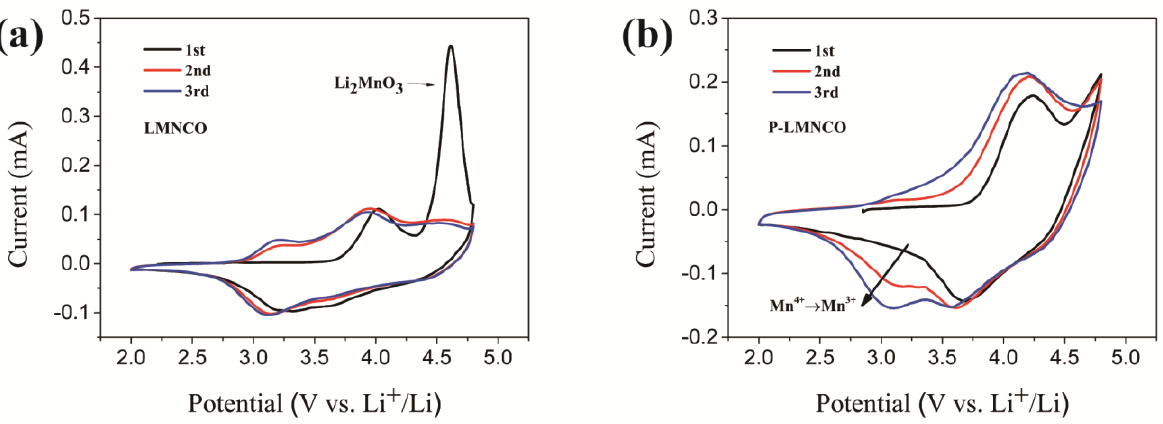
Figure 5. Cyclic-voltammograms of ( a ) LMNCO and ( b ) P-LMNCO. The polypyrrole-coated nanotube electrode shows an excellent cyclic performance.